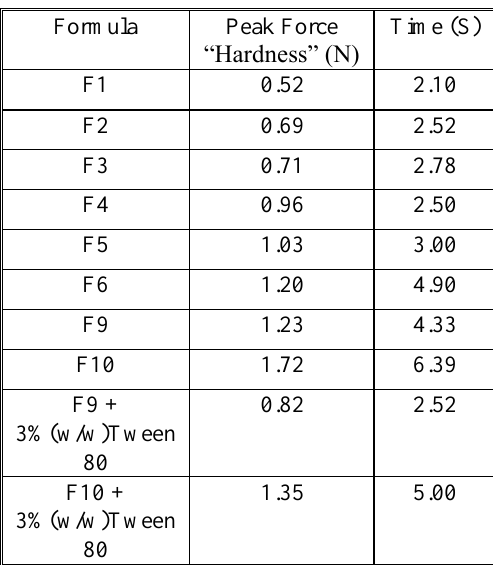
Table 3. Peak force and the time required for fracture of some of LXN MN formulas using Texture Analyzer.